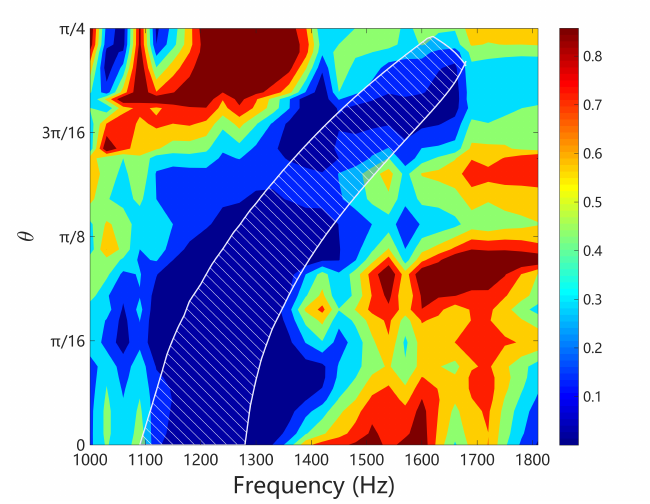
Figure 21. The angular distribution of the kinetic energy (normalized in percentage) at the monitoring points from 1000Hz to 1800Hz. The while patched area indicates the angular frequency location of the coupled band gap predicted by WFEM and identified by RSW, as shown in Figure